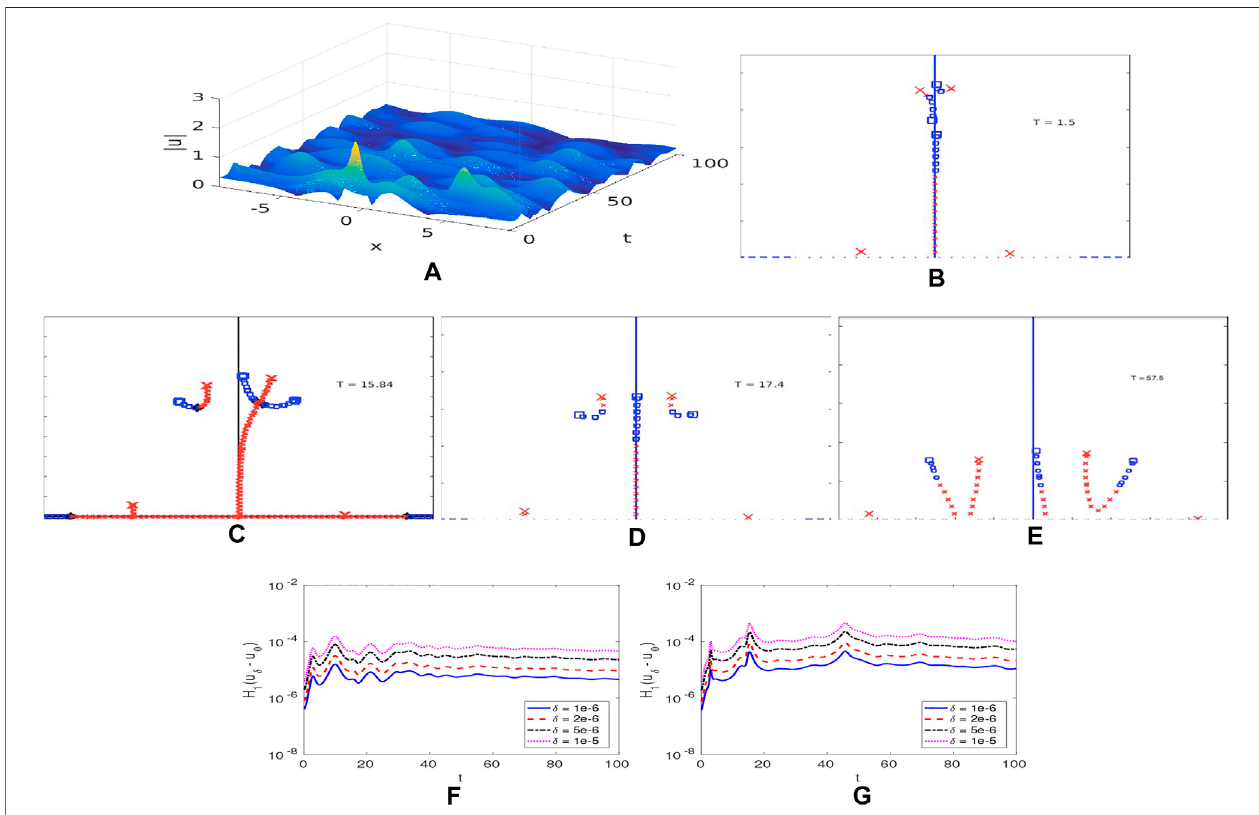
(cid:12)(cid:12)(cid:12)(cid:12)(cid:12) (cid:12)(cid:12)(cid:12)(cid:12)(cid:12) FIGURE 8 | Two UM regime: (A) U ( 1 , 2 ) ε , c ( x , t ) for 0 ≤ t ≤ 100 and spectrum at (B) t (cid:1) 1 . 5, (C) t (cid:1) 15 . 84, (D) t (cid:1) 17 . 4, (E) t (cid:1) 57 . 5, and η ( t ) for U ( 1 , 2 ) ε , c ( x , t ) with f 1 ( x , t ) when (F) ρ (cid:1) 0 , τ (cid:1) − 2 (the uncoalesced SPB), (G) ρ (cid:1) 0 . 665 , τ (cid:1) 1 (the coalesced SPB). right traveling wave as was U ( 2 ) ε , c ( x , t ) in the 2 UM regime. The spectrum at t (cid:1) 0 is given in Figure 9B . The end point of the (cid:1) 0 . 7 i is indicated by a “ box ” . There are band of spectrum, λ s 0 (cid:1) 0 . 677 i , λ d (cid:1) 0 . 604 i , and three complex double points at λ d 1 2 (cid:1) 0 . 456 i indicated by an “ × ” , “ box ” and “ × ” , respectively. λ d 3